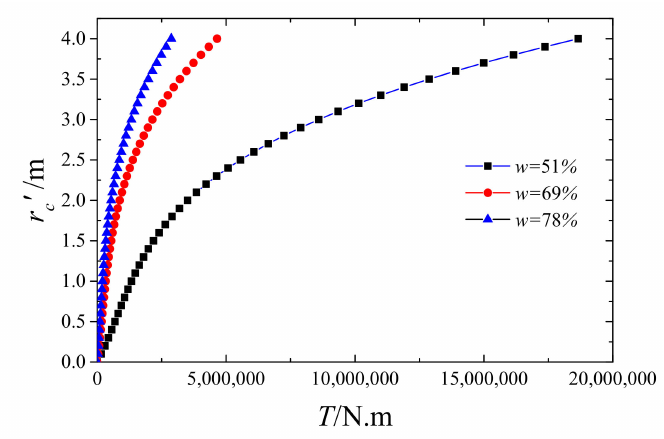
Figure 6. Torque and sheared region boundary.